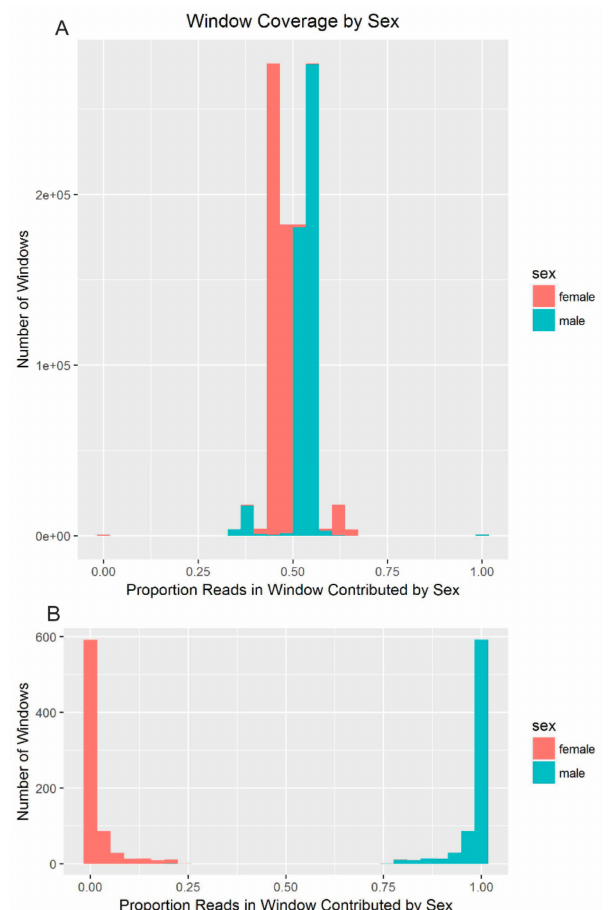
Figure 3. Comparison of male and female coverage of windows. ( A ) In each window, the percent of the mapped reads coming from the male and from the female resequencing data was calculated. Due to the depth of coverage in the male resequencing data being slightly higher, there is some displacement of the autosomal and X-chromosome curves o ff 50% and 33 / 67%, respectively. The expected pattern of density distribution is apparent, with males and females contributing roughly equal numbers of reads to most windows. Very small peaks are apparent at 0% and 100% that correspond to primarily male contribution. ( B ) Zoomed-in depiction of only the small peaks that represent 75% or more contribution from a single